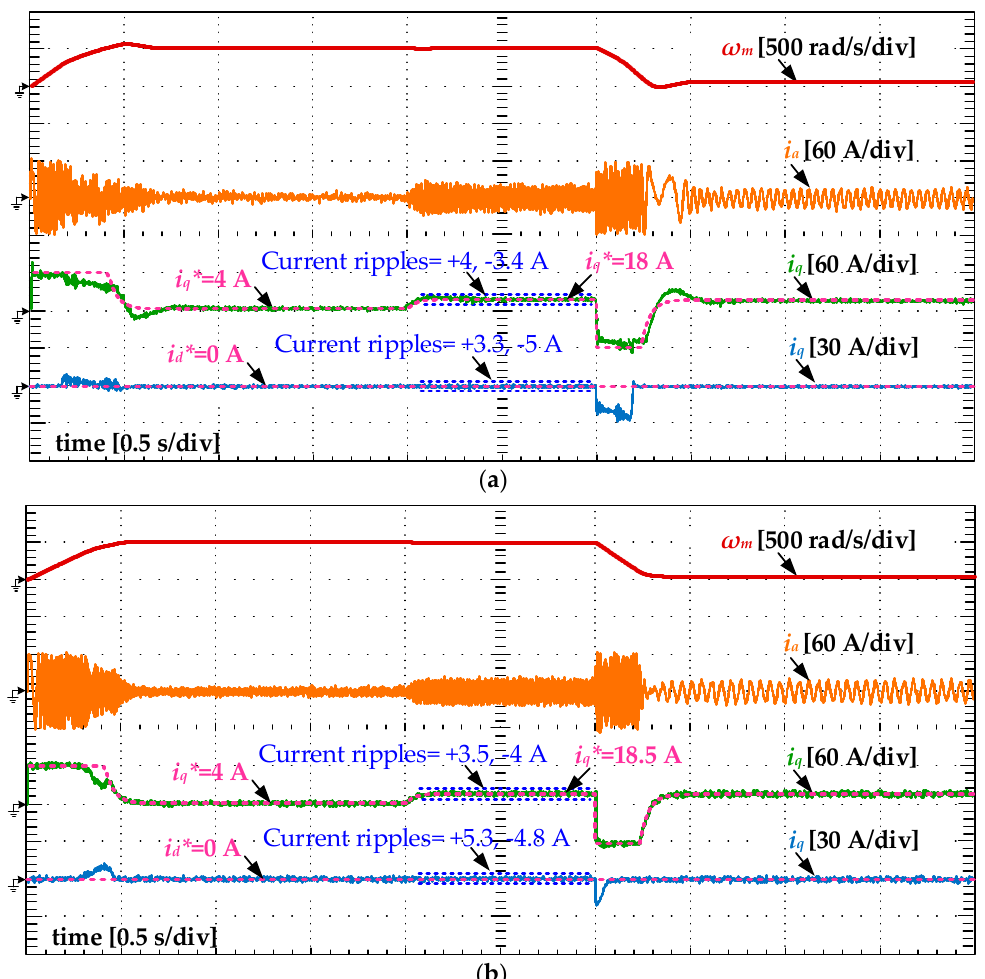
Figure 11. Experimental results under no parameter disturbances: ( a ) Traditional proportional integrate (PI)-based method. ( b ) FCS-MPCC method.